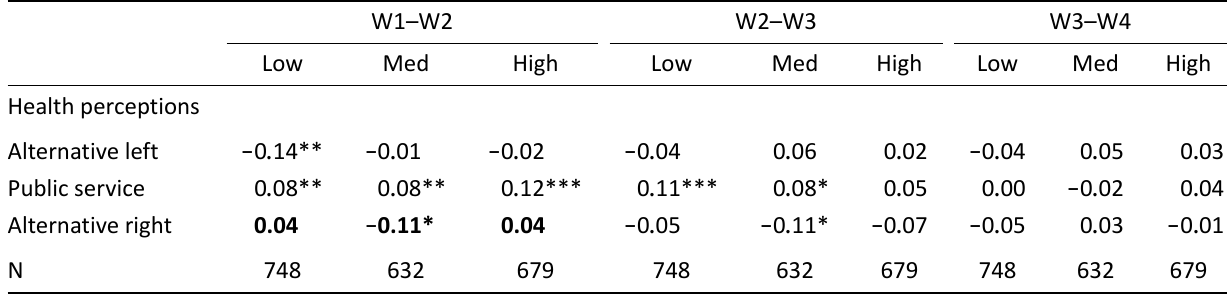
Table 1. Multiple group comparison across levels of media trust (unstandardized